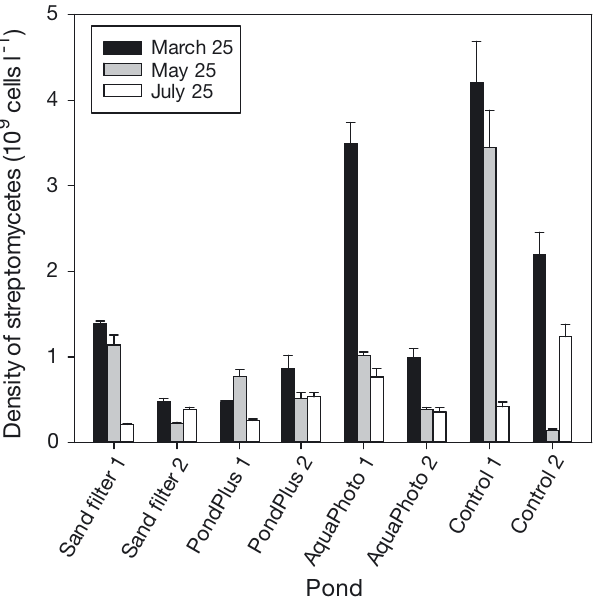
Fig. 1. Abundance of Streptomyces in the different ponds during the growth period. Mean values of triplicate samples (on filter divided into 3 portions) ± 1 SD are